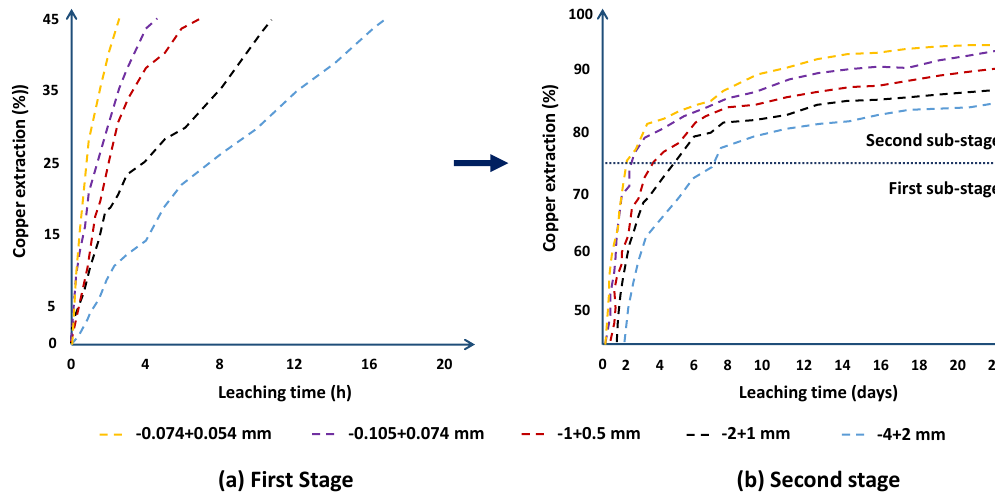
Figure 7. Cu 2 S dissolution at different particle sizes in two different stages: ( a ) first stage, ( b ) second stage ([Fe 3+ ] = 10 g/dm 3 , pH = 1.00–1.50, Eh = 750 mV, temperature = 45 °C) (Modified from: [12]).